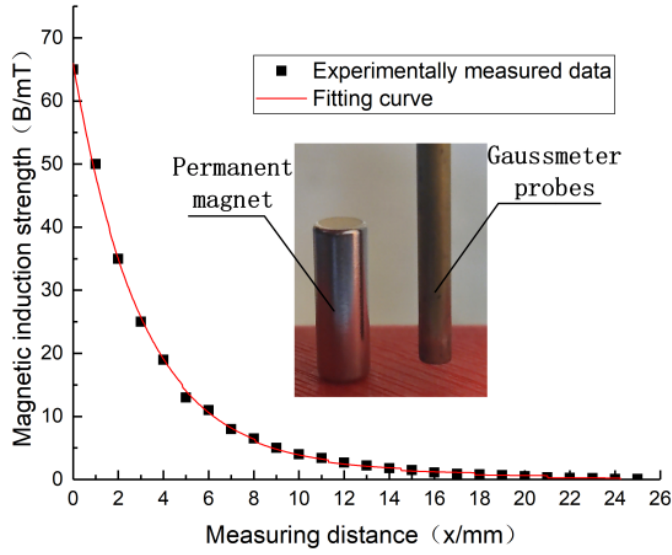
Figure 11. Transverse magnetic induction intensity of permanent magnet knitting needle.